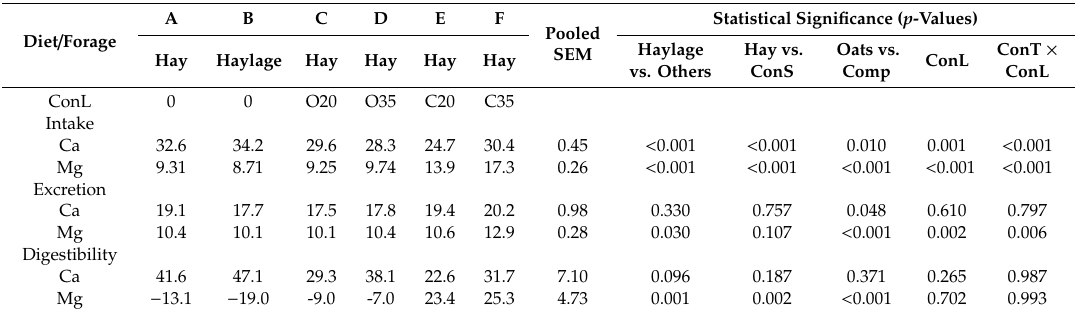
Table 4. Daily intake (g), excretion (g) and digestibility (%) of calcium (Ca) and magnesium (Mg). Diet /